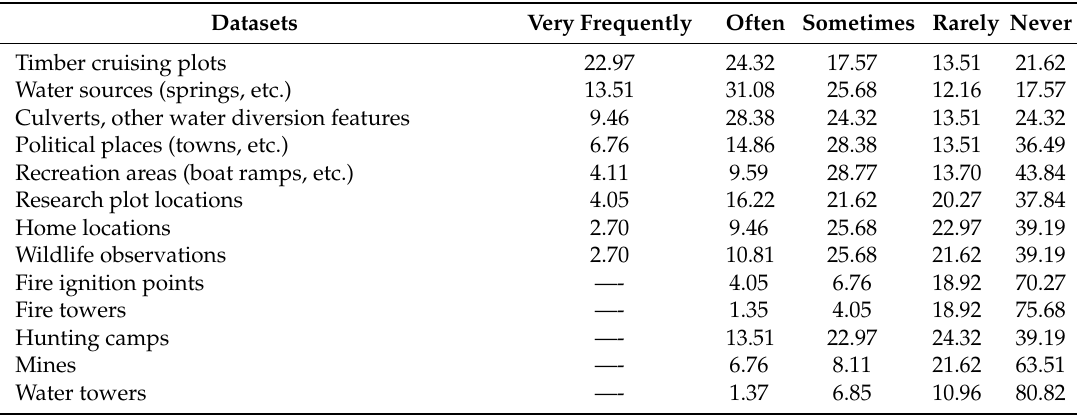
Table 3. Frequency of use (percent of respondents) of vector point datasets by recent graduates from forestry programs at Mississippi State University, Oregon State University, and the University of